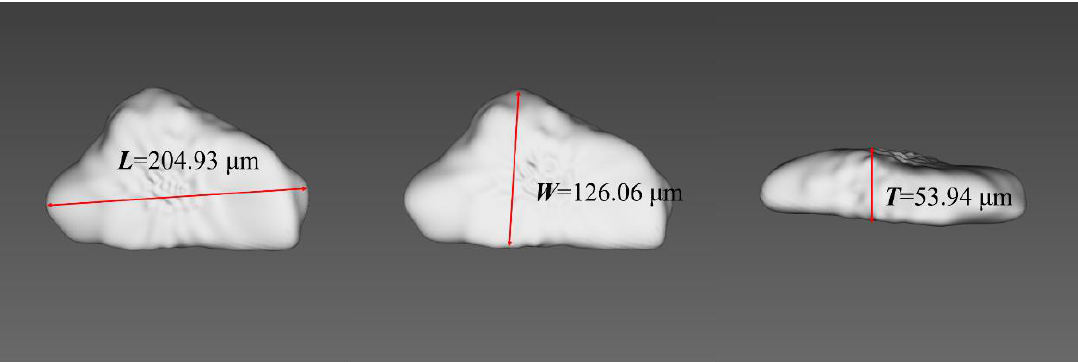
Figure 2. For a desert sand particle, the definitions of length ( L ), width ( W ), and thickness ( T ), with L ≥ W ≥ T and L ⊥ W ⊥ T .